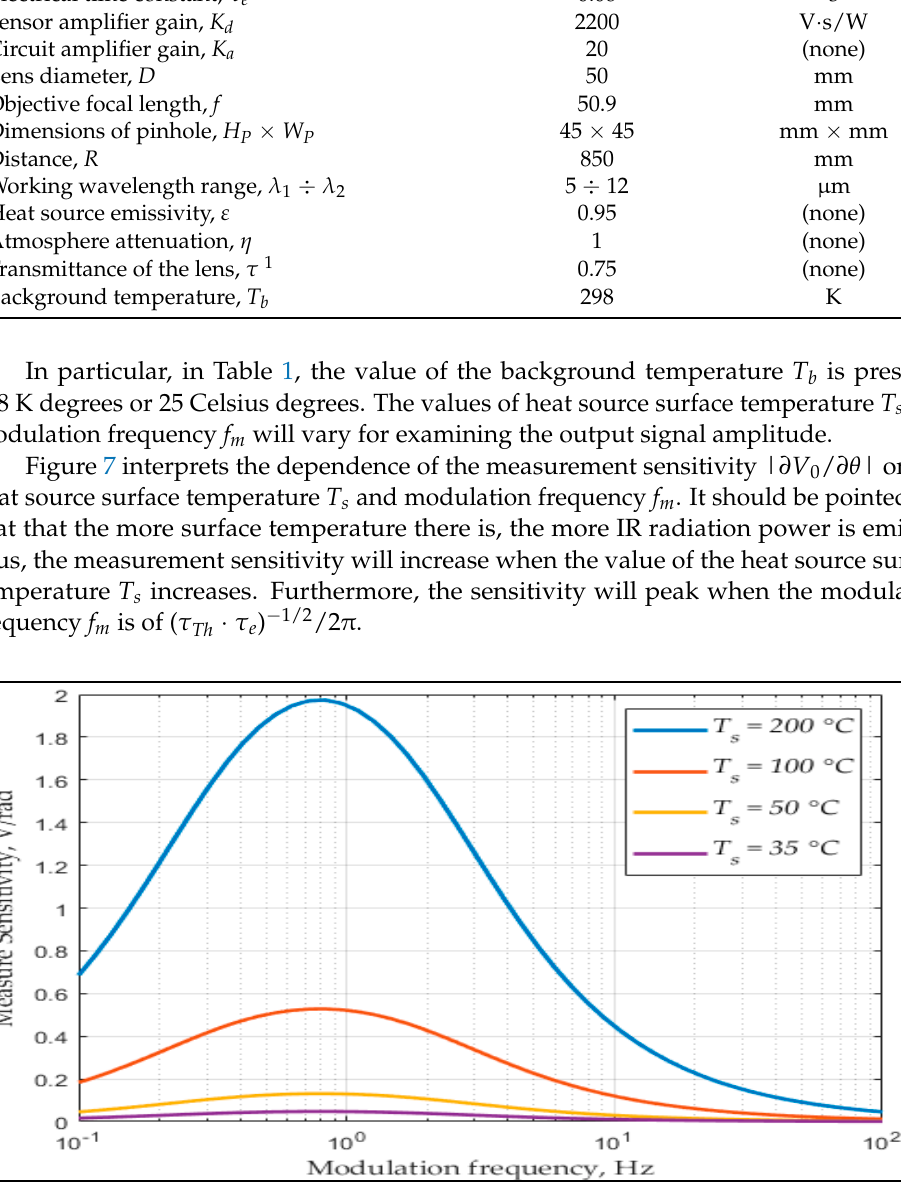
Figure 7. Simulation result for measurement sensitivity over frequency with different settings of heat source temperature.